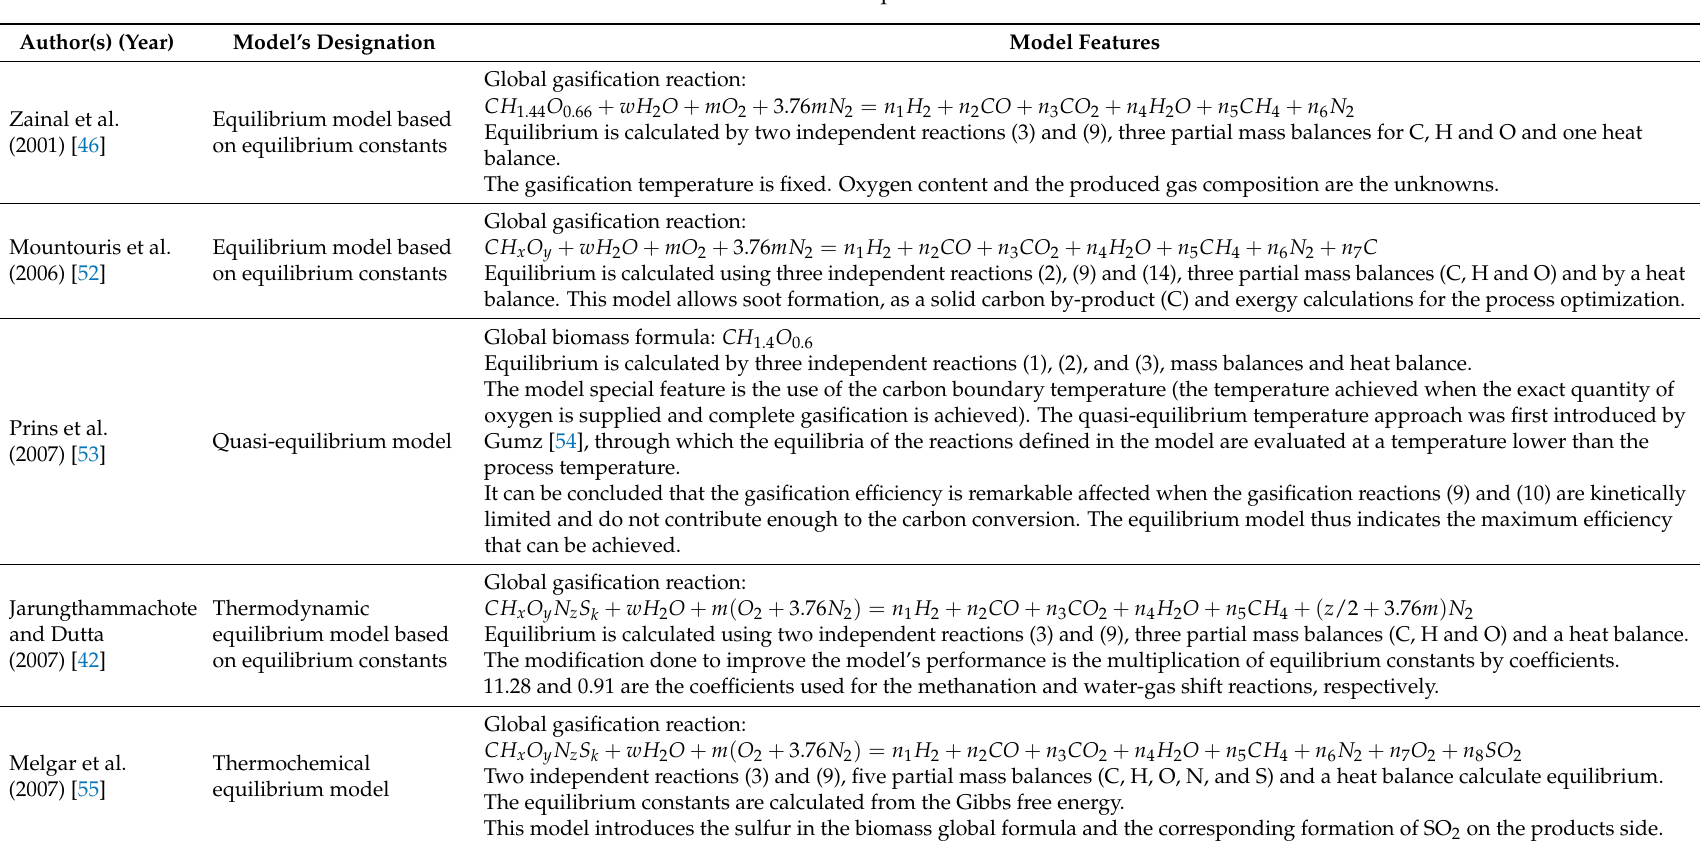
Table 3. Stoichiometric equilibrium